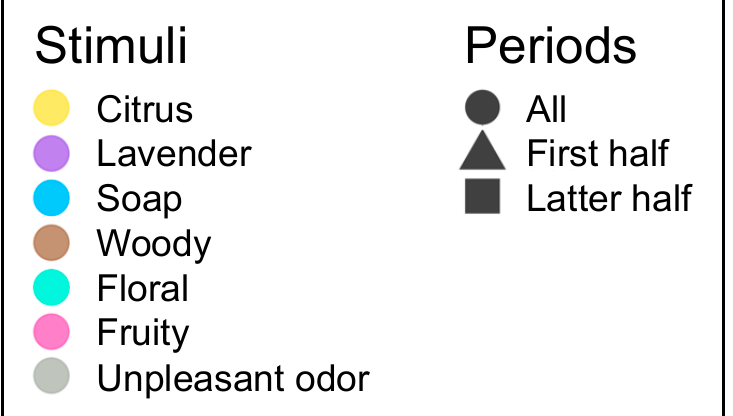
Figure 10. Legend for emotion map.